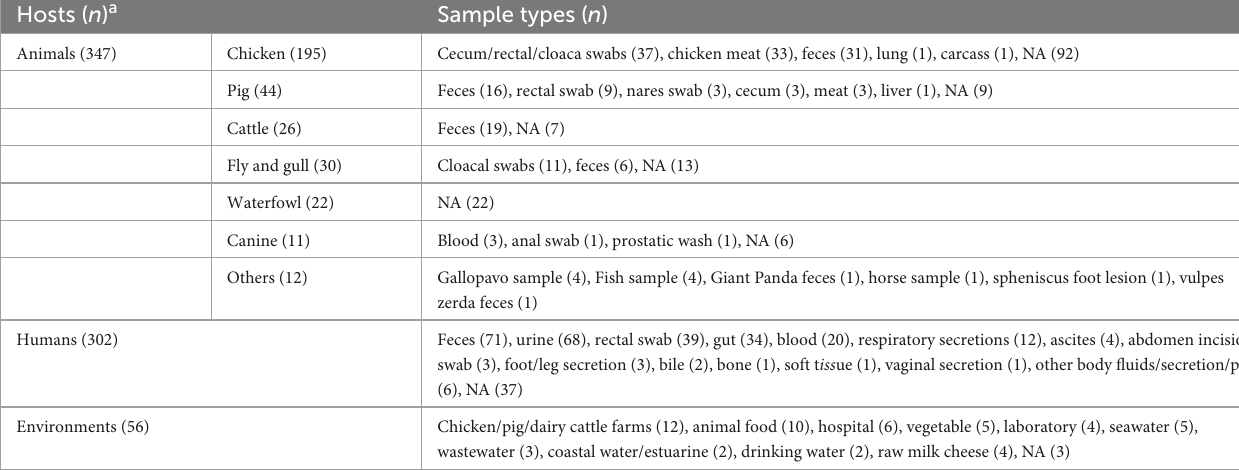
TABLE 1 The hosts and sample types of mcr-positive Escherichia coli isolates